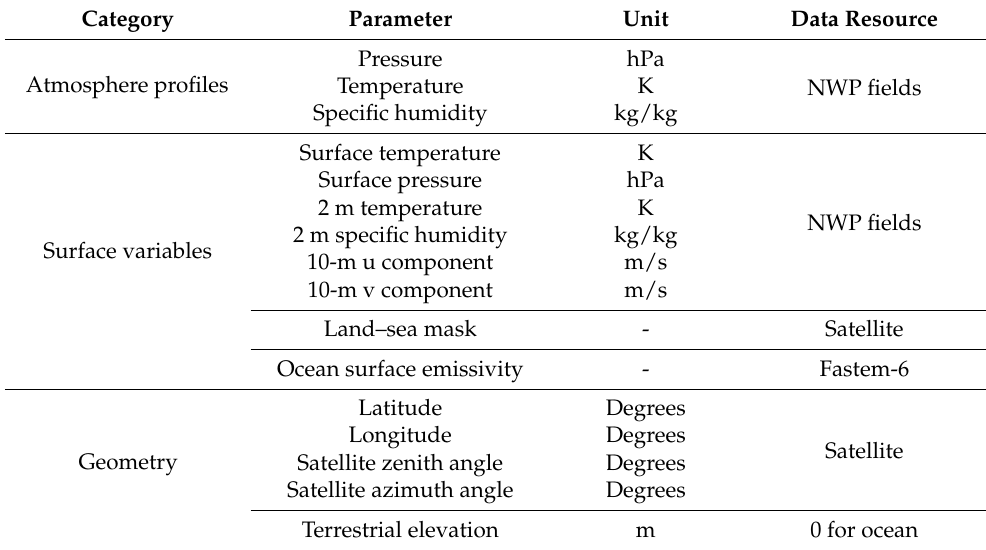
Table 2. Input parameters of RTTOV.